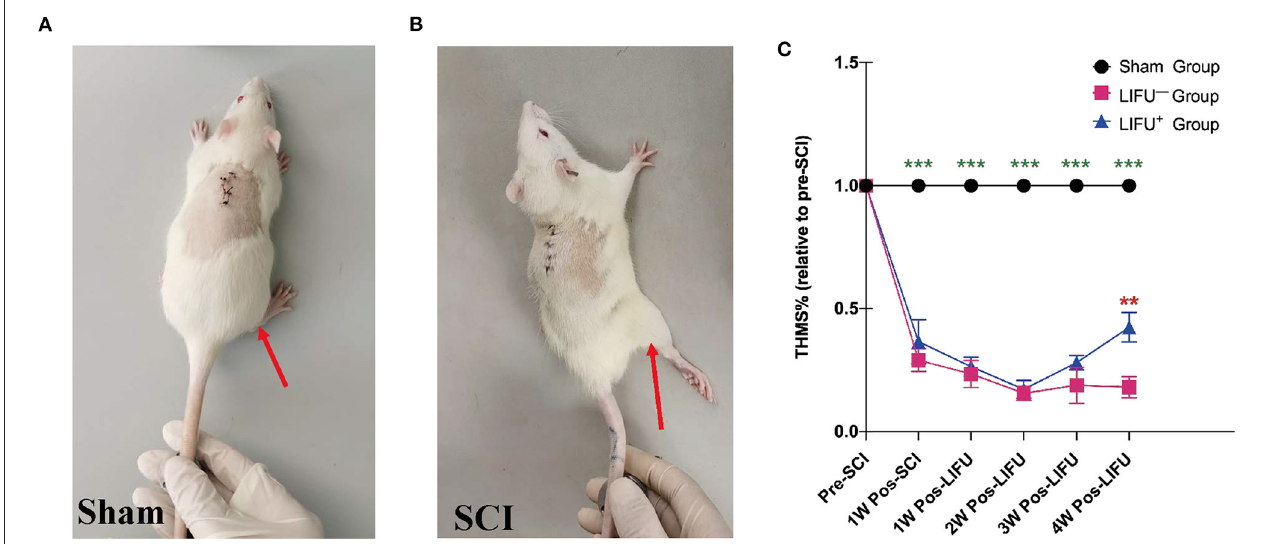
FIGURE 3 | Threshold hold (g) of mechanical stimulation (THMS) test for the spasm. (A) A normal hind limb motor response to tail pinching was shown by the sham operation rats. (B) A typical hind limb motor response to tail pinching was shown by the spinal cord injury (SCI) rats. (C) This shows the THMS responses to tail pinching. *** P < 0.001, compared with the sham group; ** P < 0.01, compared with the LIFU − group; one-way analysis of variance (ANOVA) with a least significant difference (LSD) test; n = 10; mean ± standard error on the mean (SEM).